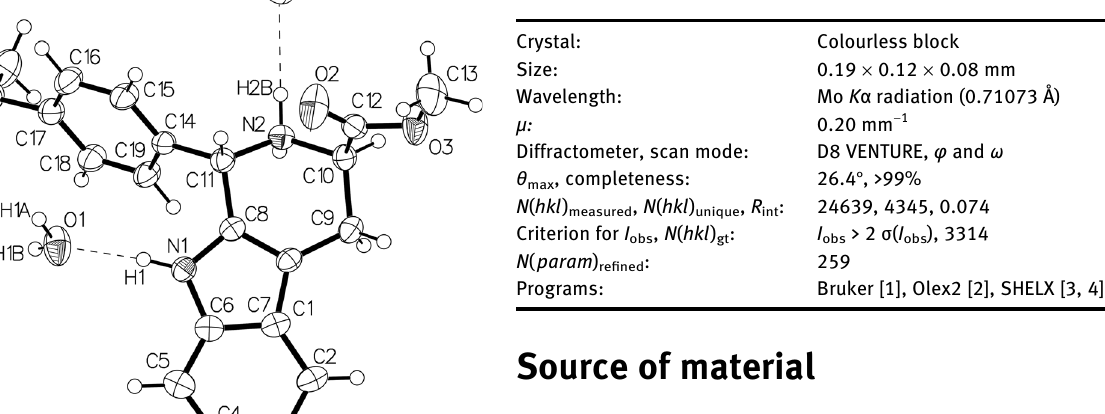
Table  : Data collection and